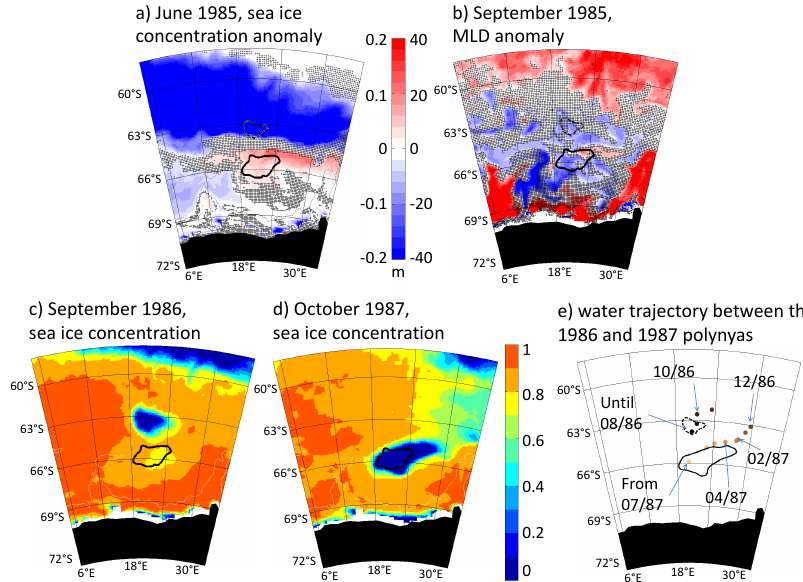
Figure 2. Chain of events leading to deep convection in 1987: (a) sea ice concentration anomaly in June 1985, (b) MLD anomaly in September 1985, (c) and (d) sea ice concentration in September 1986 and October 1987, and (e) trajectory of the water between the two polynyas of 1986 (dashed black line) and 1987 (continuous black line, see text). Stippling on (a) and (b) indicates areas where the anomalies are not significant. Dashed contours on (a) and (b) indicate the location of the 1986 polynya. Black contours on (a) – (d) indicate the area where the maximum MLD from Fig. 1 exceeds 2000m, while grey contours indicate the 3000m isobath.